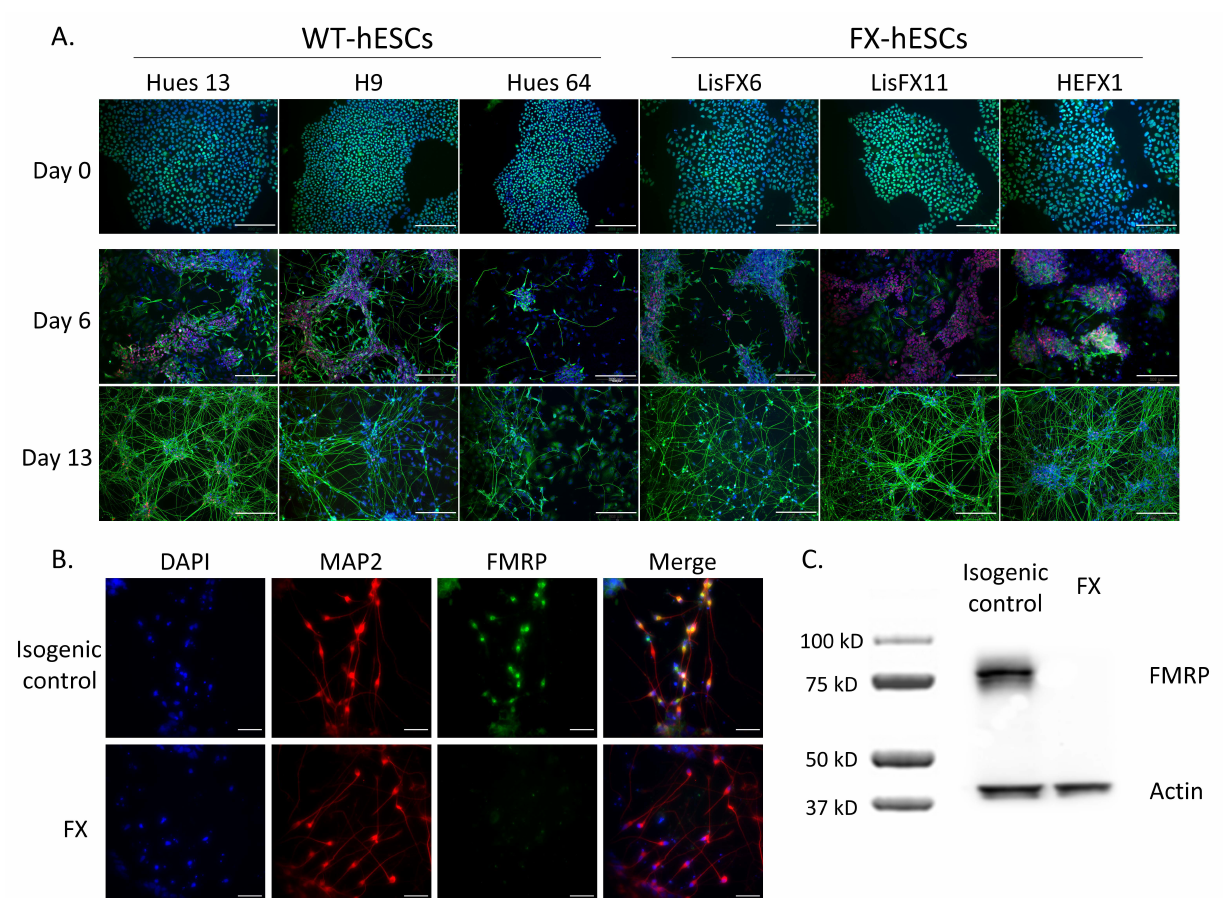
Figure 1. Delayed early neurodevelopment is concomitant with FMR1 silencing. ( A ) Immunoflu- orescence staining of three FX- and three WT-hESC lines at 0, 6, and 13 DIV of accelerated neural differentiation, with the pluripotent marker POU5F1 (OCT4, green) and the neural genes β -III tubulin (Tuj1) (green) and the neural precursor marker PAX6 (red). Cell nuclei were stained blue by DAPI. Scale bar: 200 µ m. ( B ) Immunofluorescence staining of a full-mutation sub-clone and its isogenic control for microtubule-associated protein 2 (MAP2) (red) and for FMRP (green), at 13 DIV. Cell nuclei were stained blue by DAPI. Scale bar: 50 µ m. ( C ) Western blot analysis of FMRP expression in 23 DIV neurons following magnetic sorting (MACS) with CD184 antibody (negative fraction). Actin served as a positive